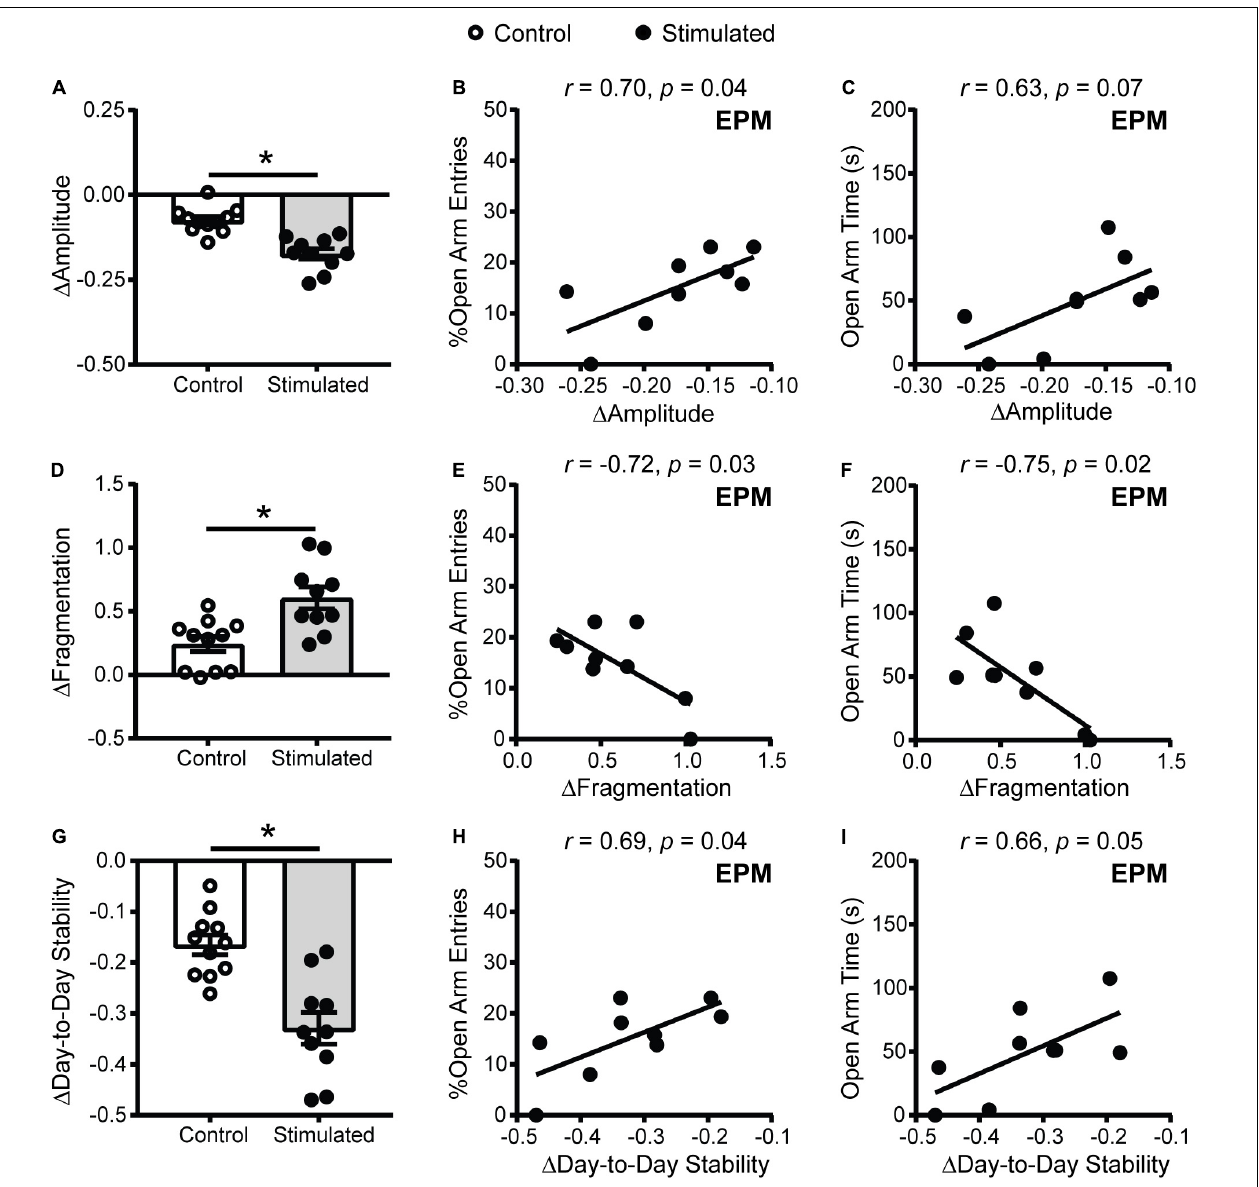
FIGURE 5 | Homecage activity non-parametric circadian parameter changes and correlations with behavior in mice that received stimulations of the SCN at unpredictable times during the dark phase. Change in homecage activity non-parametric circadian parameters were measured relative to baseline in LD. (A) Stimulated mice had a greater reduction in homecage activity amplitude, (D) increase in fragmentation and (G) decrease in day-to-day stability. Correlations between the change in (B,C) homecage activity amplitude, (E,F) fragmentation and (H,I) day-to-day stability with behavior in the EPM in stimulated mice. n = 9–11 Vgat -Cre;ChR2 mice. * p <